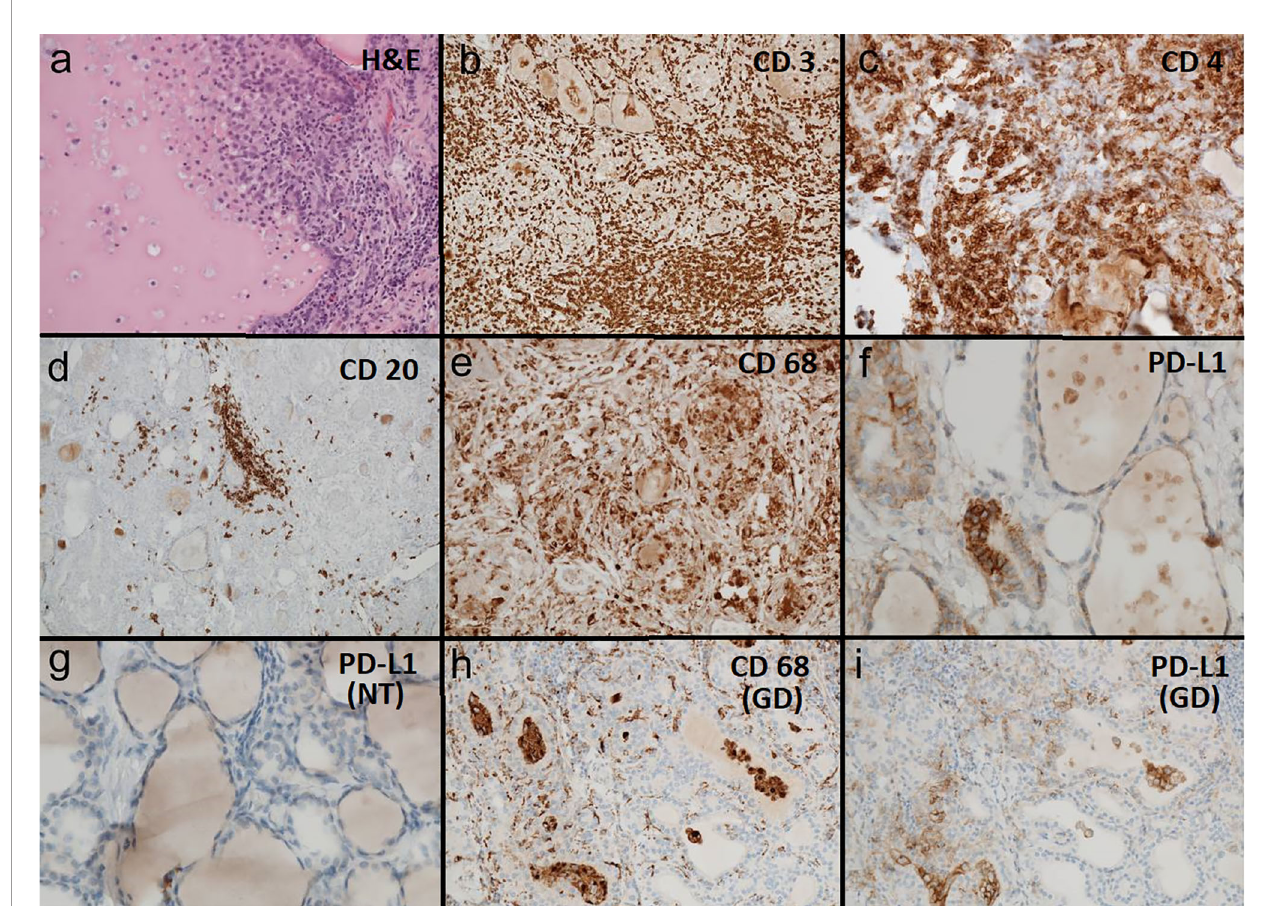
FIGURE 2 | (A – F) Pembrolizumab induced thyroiditis: (A) H&E 200x: thyroid tissue with follicle partially destucted by histiocytes. (B) CD3 100x: thyroid tissue densely in fi ltrated by CD3 reactive T-lymphocytes. (C) CD 4 200x: thyroid tissue densely in fi ltrated by T helper cells (CD4 reactive). (D) CD 20 100x: thyroid tissue sparsely in fi ltrated by CD20 reactive B-lymphocytes. (E) CD 68 200x: thyroid tissue densely in fi ltrated and partially destructed by CD68 reactive histiocytes. (F) PD- L1 (SP263 hemalum2 8min) 400x: thyroid follicle partially destructed by histiocytes with coexpression of PD-L1 (clone SP263). (G) Regular thyroid tissue: PD-L1 (SP263 hemalum2 8min) 400x: normal thyroid tissue without PD-L1 (clone SP263) reactive cellular elements. (H, I) Graves´ Disease: (H) CD68 reactive histiocytes in the stroma and in thyroid follicles. (I) Histiocytes in the stroma and in thyroid follicles showing coexpression of PD-L1 (clone